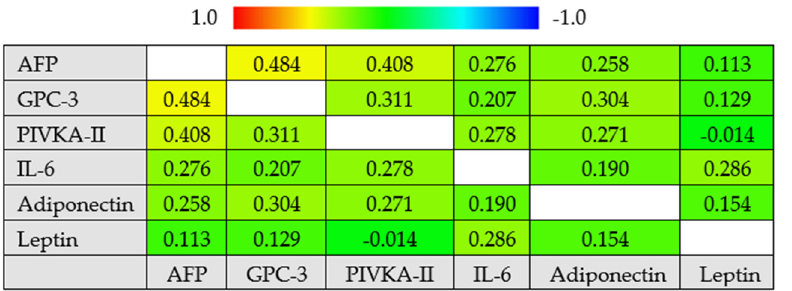
Figure 2. Correlogram of the biomarkers’ concentrations. Cells are colored according to the magnitude of the correlations, ranging from dark red for positive correlations to dark blue for negative correlations. Correlation coefficients ( r s ) were calculated by the Spearman test. Abbreviations: alpha-fetoprotein (AFP), glypican 3 (GPC3), hepatocellular carcinoma (HCC) and interleukin-6 (IL-6).